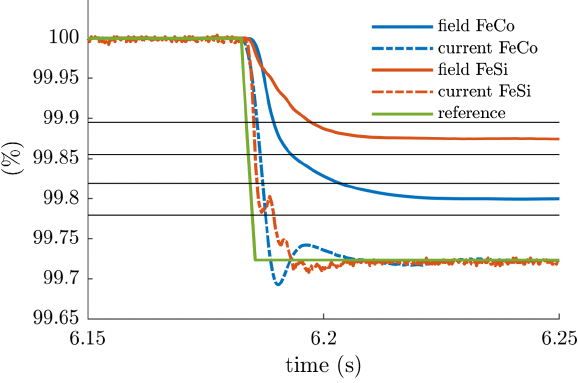
FIG. 22. High current step delay.